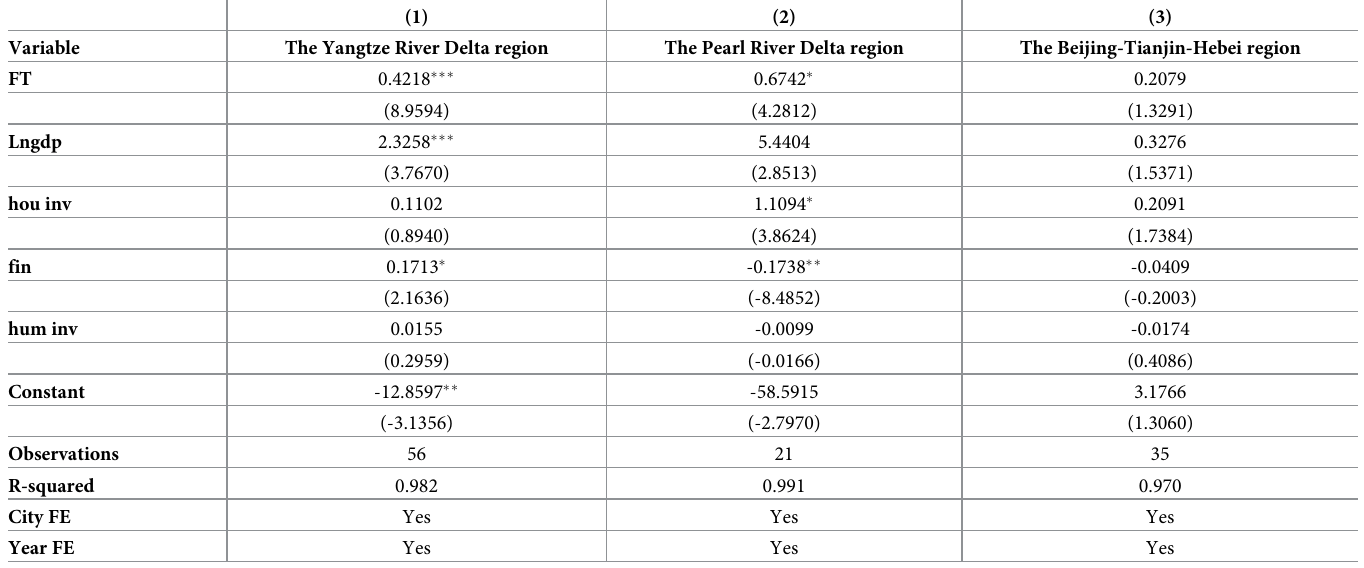
Table 9. Regression classified by major migration